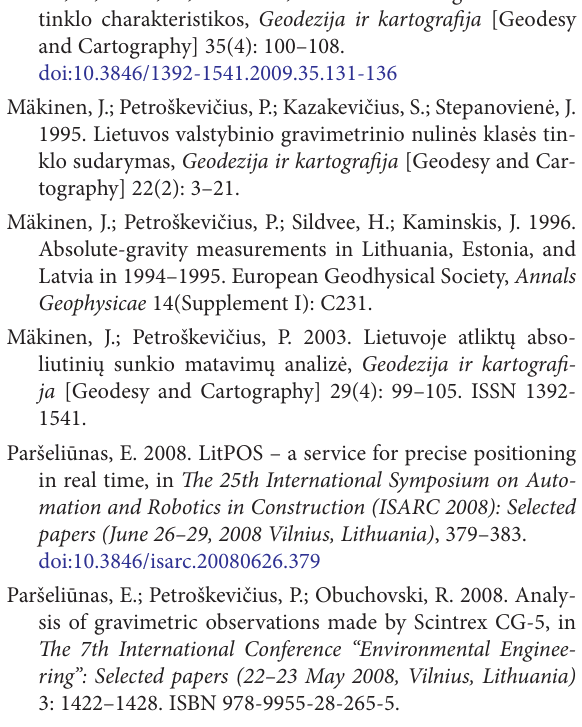
Fig. 3. Gravity acceleration differencies (after elimating avereage value of the differences), mGal